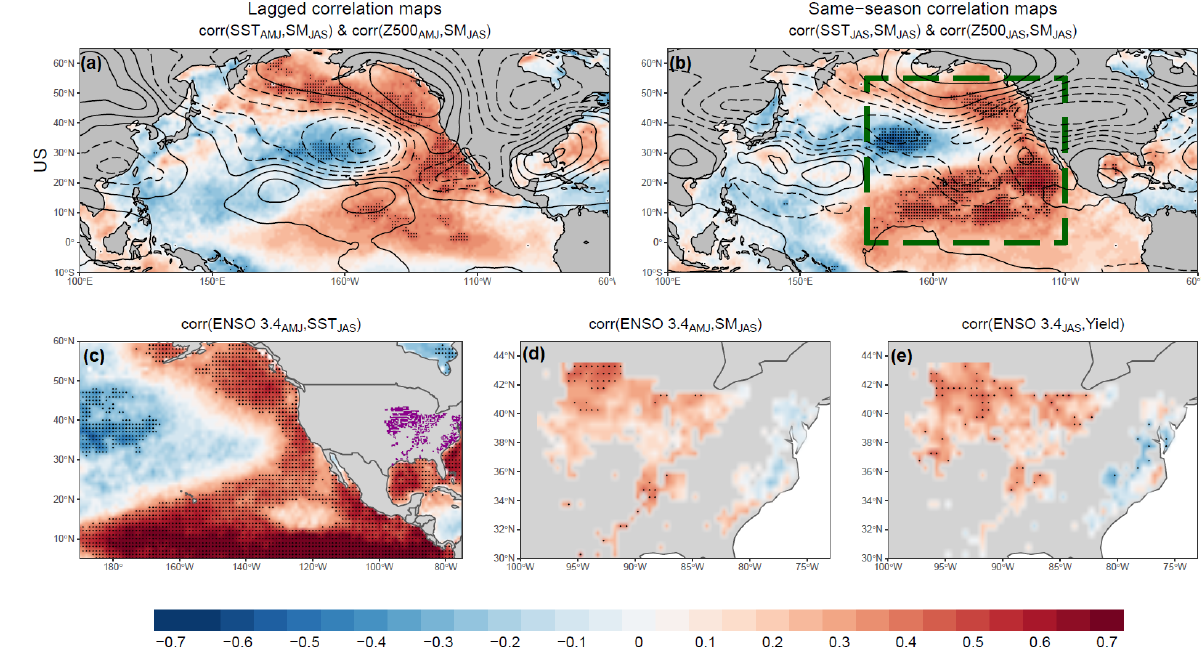
Figure 4. (a, b) Correlation maps at both lagged and same-season time steps for Z500 (contours) and SST (colors) against boreal summer (JAS) soil moisture. Contour lines represent Z500 correlations with 0.1 increment, whereas negative values are dashed. (c–e) Correlation maps for lagged AMJ ENSO 3.4 index against boreal summer SST (JAS), soil moisture (JAS) and yield anomaly in the US. Stippling indicates statistical significance ( P FDR < 0 . 05) after having corrected for false-discovery rate using the Benjamini–Hochberg correction. The green rectangle in (b) indicates the SST area used to calculate the spatial covariance time